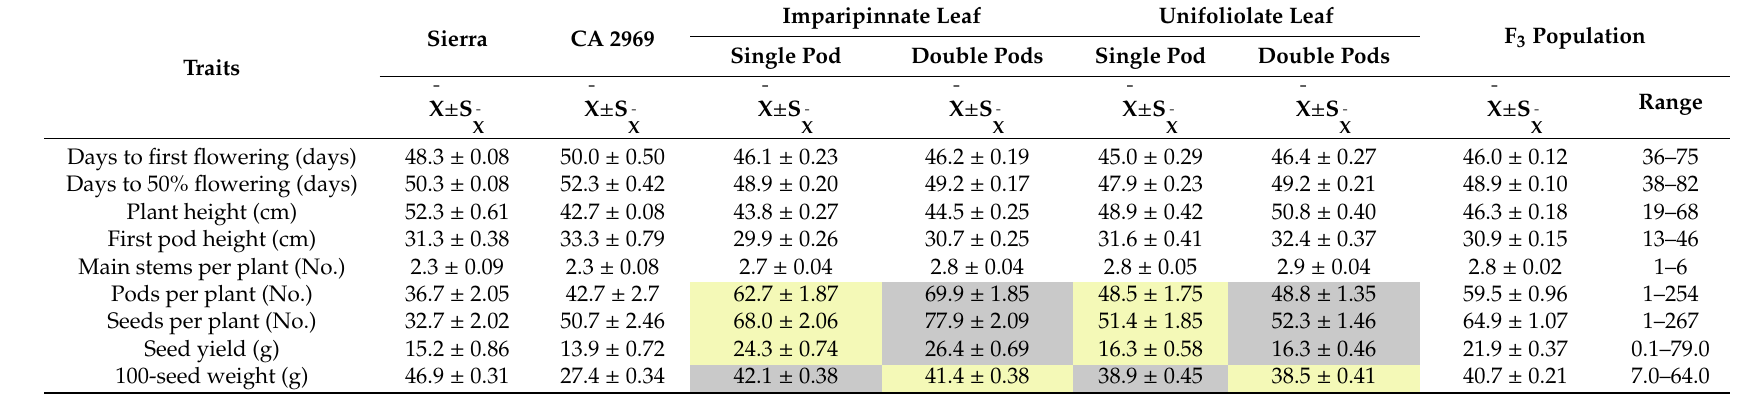
Table 3. Means ± standard errors and ranges for agro-morphological traits in F 3 derived from intraspecific crosses between Sierra (single-podded and unifoliolate leaf) and CA 2969 (double-podded and imparipinnate leaf).